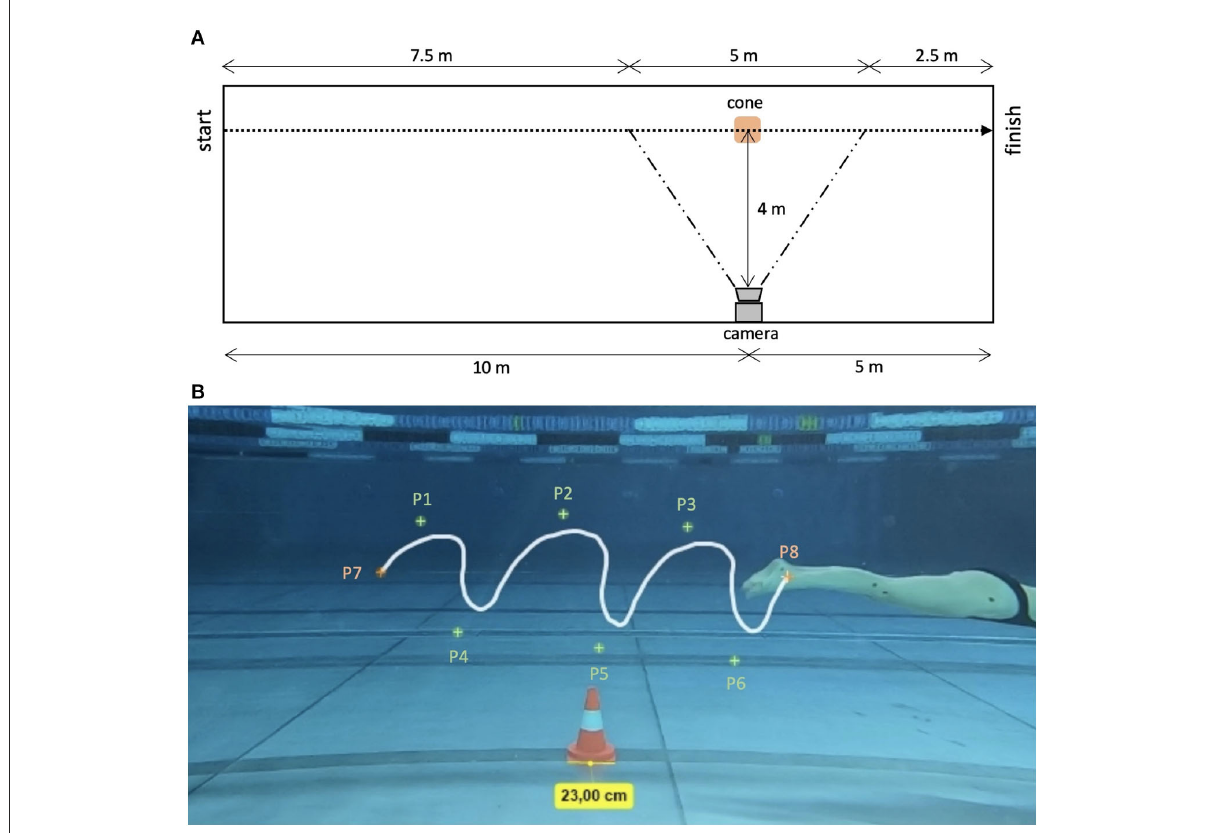
FIGURE1 Experimental set-up (A) and motion analysis of swimming trial by tracking bony landmarks (B) . P1–P3 and P4–P6 mark the highest and lowest points of the fifth toe during kicking cycles. P7 and P8 mark the start and end points of three kicking cycles.